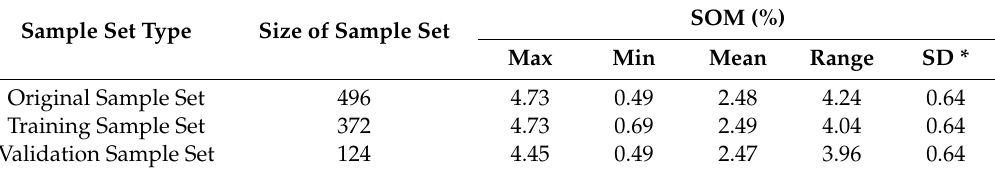
Table 1. Statistics for Di ff erent Sample Sets.